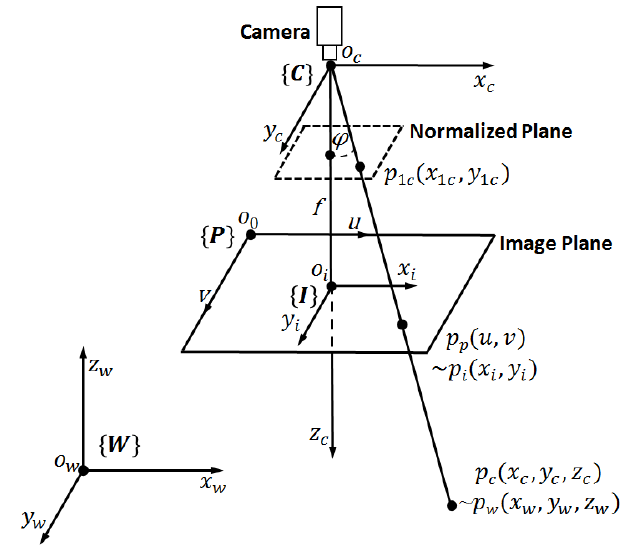
Figure 9. Coordinate system of a monocular camera.